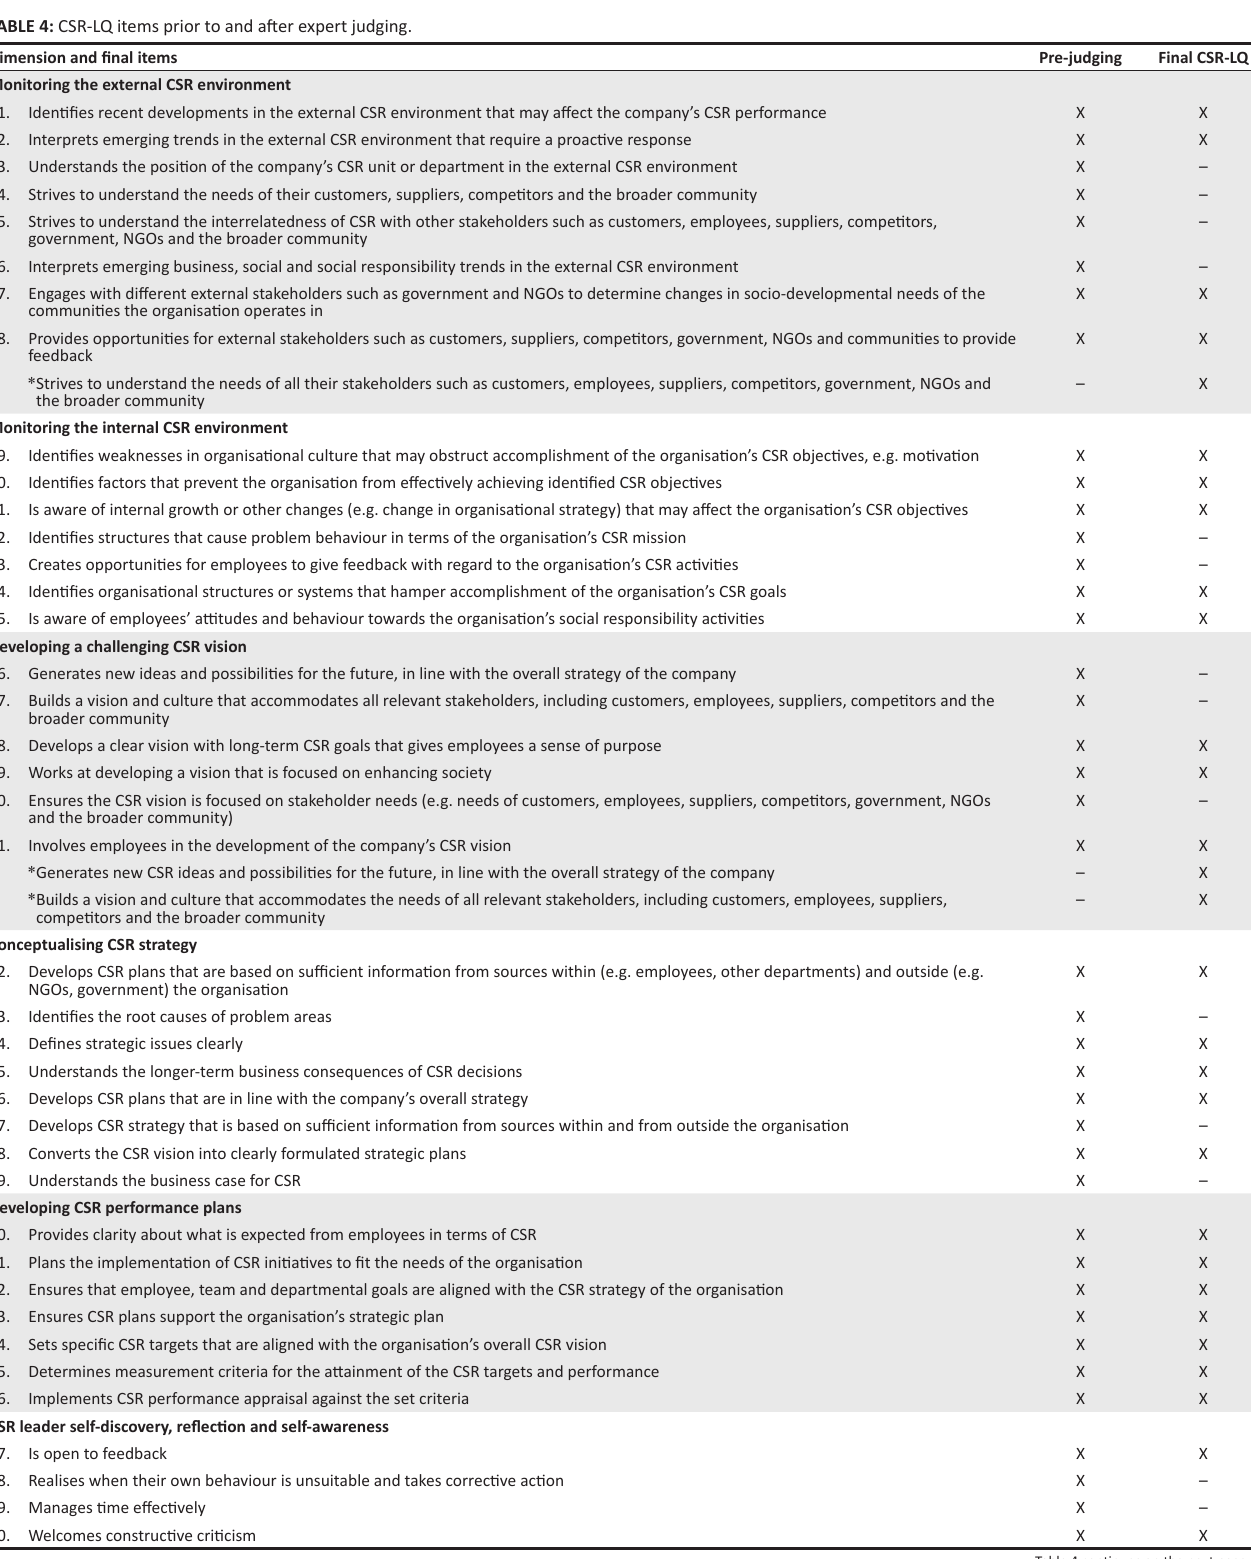
TABLE 4: CSR-LQ items prior to and after expert